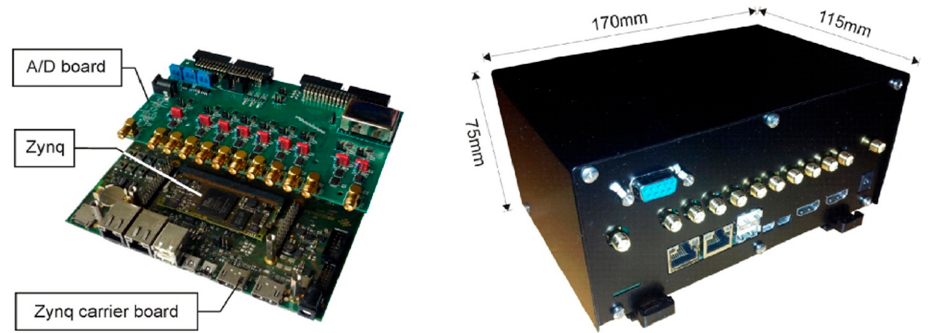
Figure 7. Laboratory test platform of the